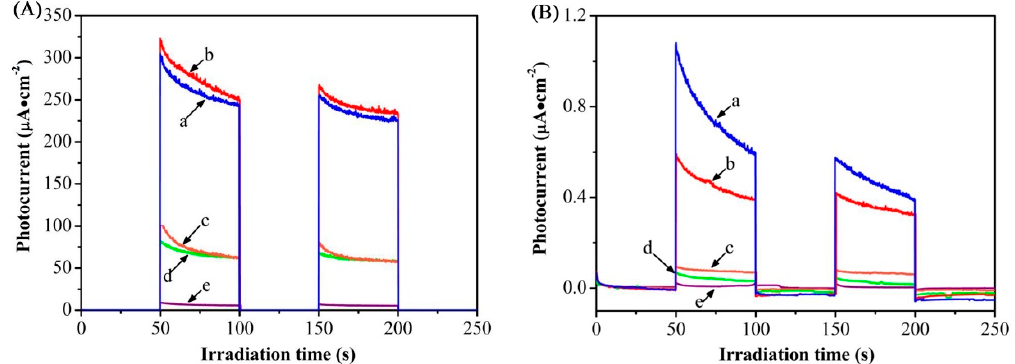
Figure 7. ( A )Photocurrent density curves under UV-Vis light irradiation of Mo-TiO 2 nanotube array films with different Mo concentrations: (a) Mo1.0, (b) Mo0.5, (c) Mo0.25, (d) Mo0 and (e) Mo–Ti thin film. ( B ) Photocurrent density curves under visible light irradiation of Mo-TiO 2 nanotube array films with different Mo concentrations: (a) Mo1.0, (b) Mo0.5, (c) Mo0.25, (d) Mo0 and (e) Mo–Ti thin film.